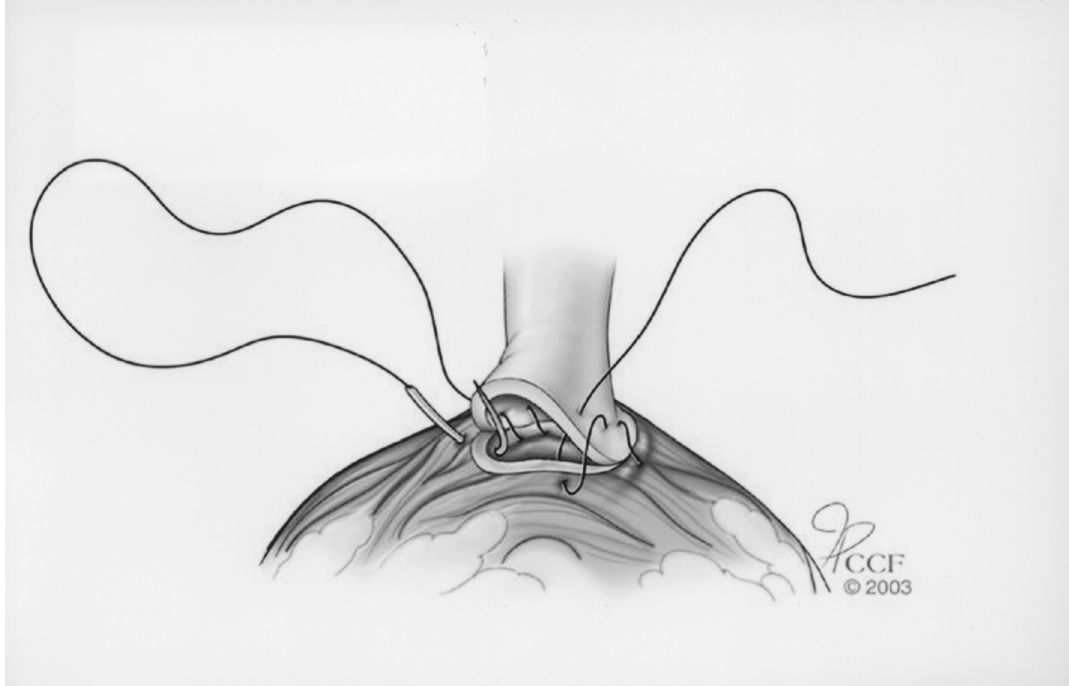
Figure 4 – Under laparoscopic visualization a precise mucosa-to-mucosa approximation is completed using running